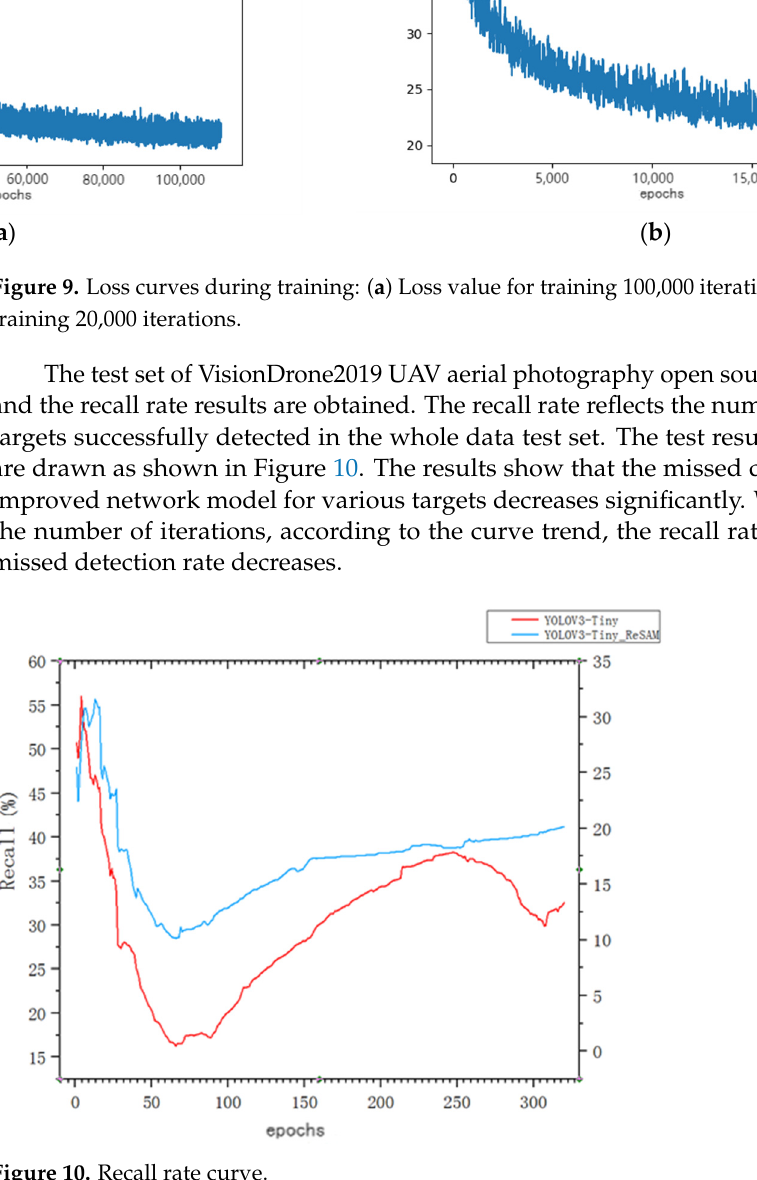
Figure 10. Recall rate curve.